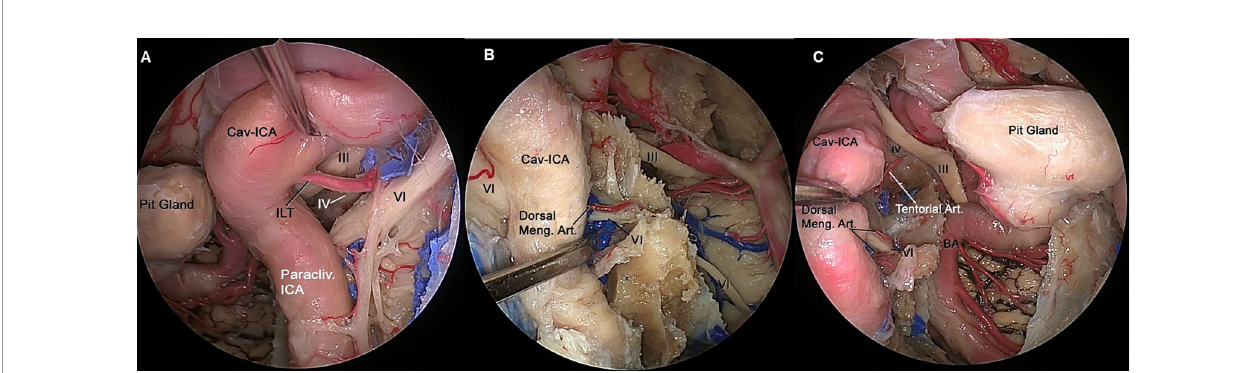
FIGURE 4 | (A) Endoscopic view of left CS showing the neurovascular relationships in the lateral compartment. The ILT arising from the midportion of the horizontal segment of the intracavernous ICA, and its branches can be identi fi ed running from medial to lateral where they distribute along the lateral wall of the CS and supplies to the of CN III, CN IV and distal CN VI. (B) The paraclival ICA is retracted laterally to expose CN VI inside Dorelo ’ s canal. Dorsal meningeal artery (Dorsal Meng. Art.), a branch from MHT, which is located in the posterior compartment of cavernous sinus and supply proximal segment of CN VI at the level of Dorelo ’ s canal. (C) Endoscopic view of right CS showing the neurovascular relationships in the superior and posterior compartment of the CS. The Cav-ICA is retracted laterally. The tentorial artery and dorsal meningeal artery can be identi fi ed running in the superior and posterior compartment of the CS, respectively. The dorsal meningeal artery supplying proximal segment of CN VI at the level of Dorelo ’ s canal and the tentorial artery supplying the CN IV are shown. BA, Basilar Artery; Cav, Cavernous; CAV-ICA, Cavernous Internal Carotid Artery; CN, Cranial Nerve; Dorsal Meng. Art, Dorsal Meningeal Artery; ICA, Internal Carotid Artery; ILT, inferolateral trunk.